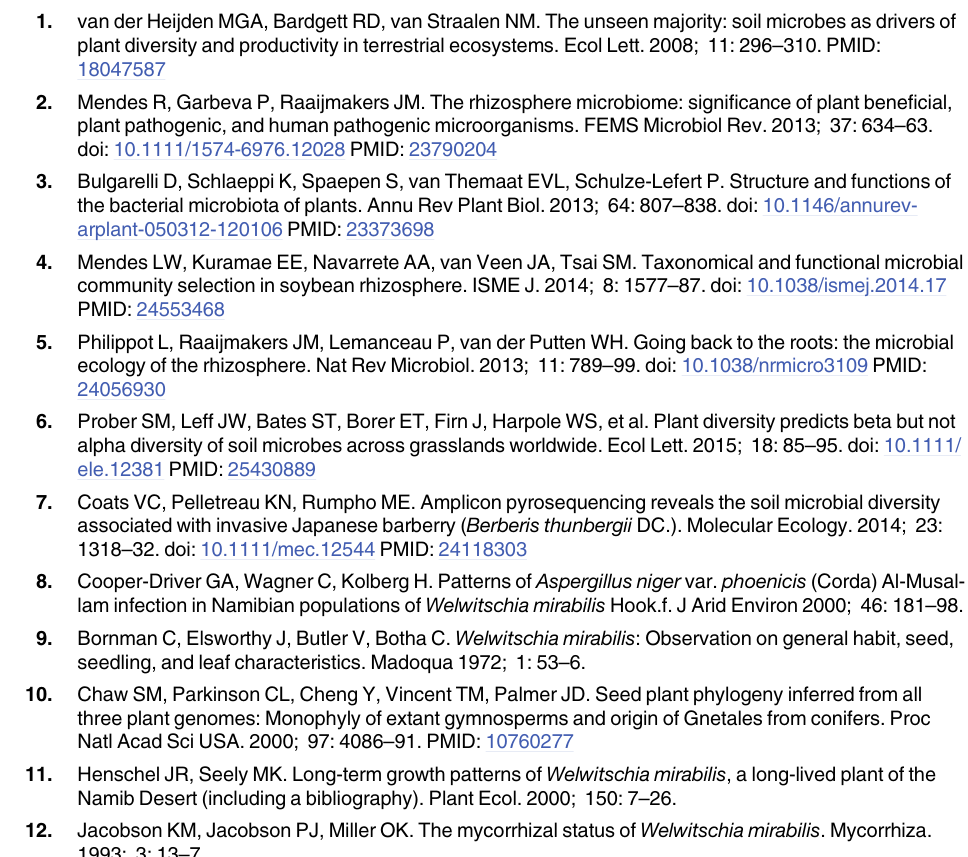
S2 Table. Fungal diversity. Sample nomenclature is as in S1